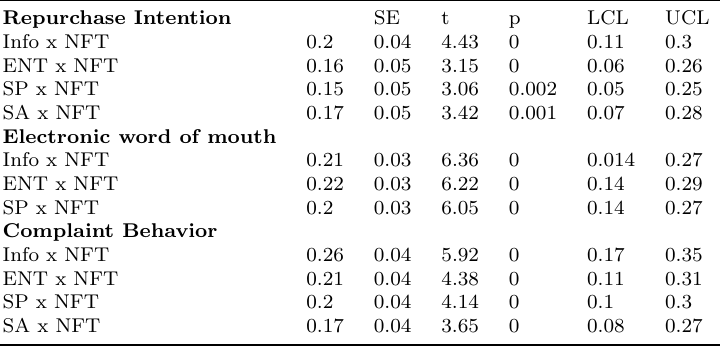
Table 7: The moderating role of